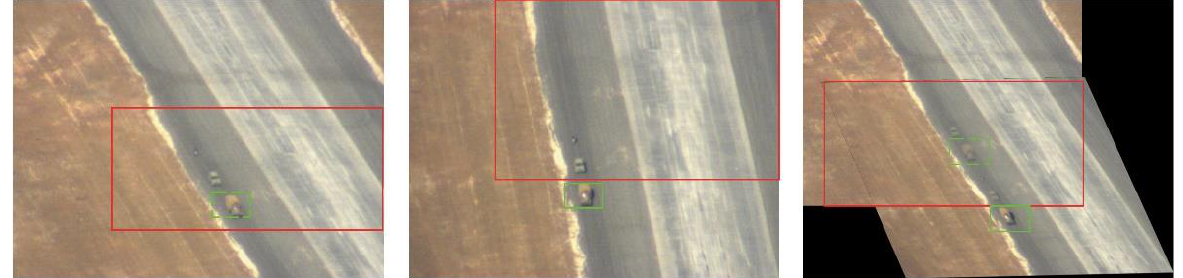
Figure 3. Schematic diagram of ghost performance.